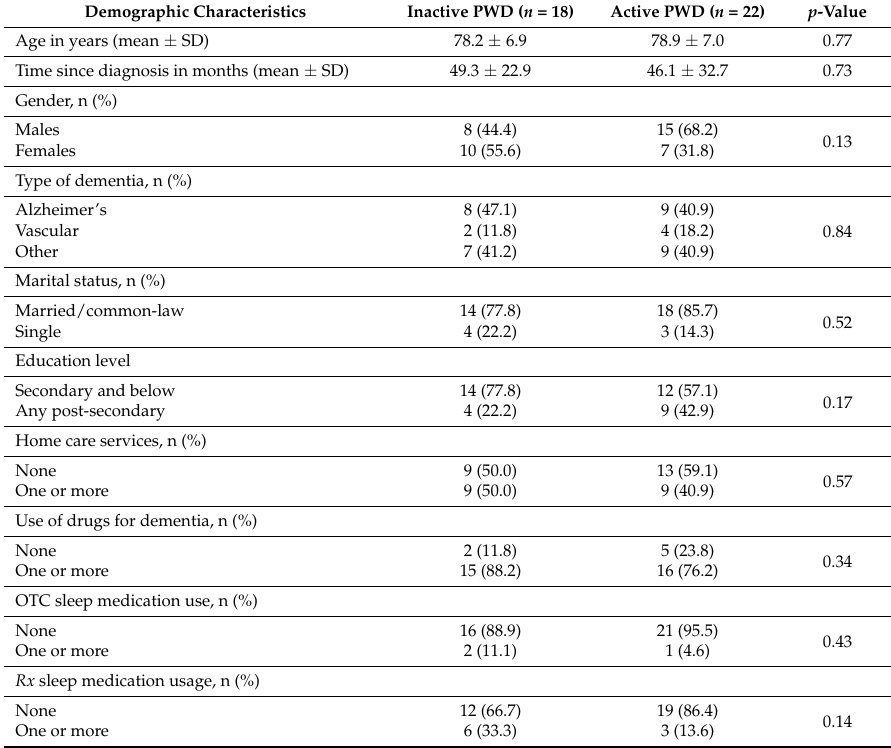
Table 1. Characteristics of PWD by activity level: active ( ≥ 1.5 kkd) or inactive (<1.5